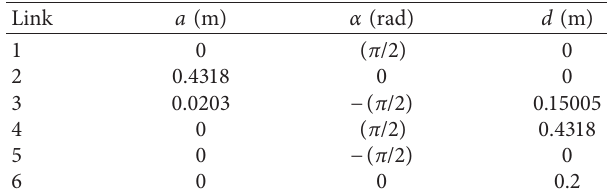
Table 2: The D-H parameter of the redundant manipulator PUMA 560 used in this